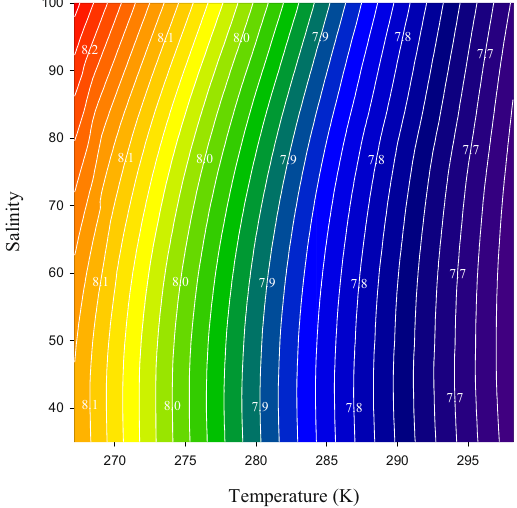
(values on contour lines) as determined in this 2 2